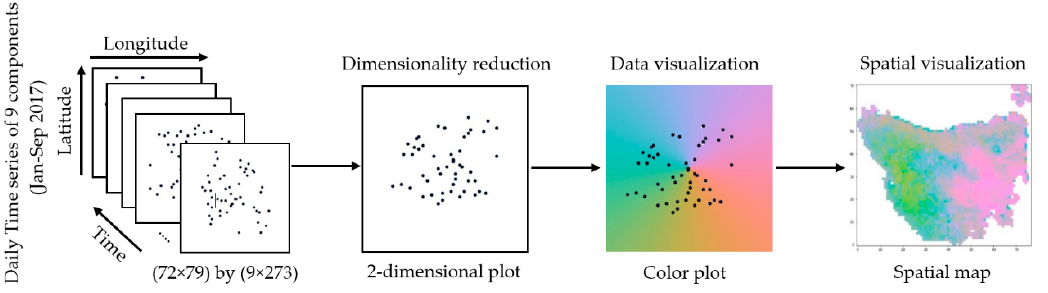
Figure 3. Visualization workflow for high-dimensional spatio-temporal gridded datasets.